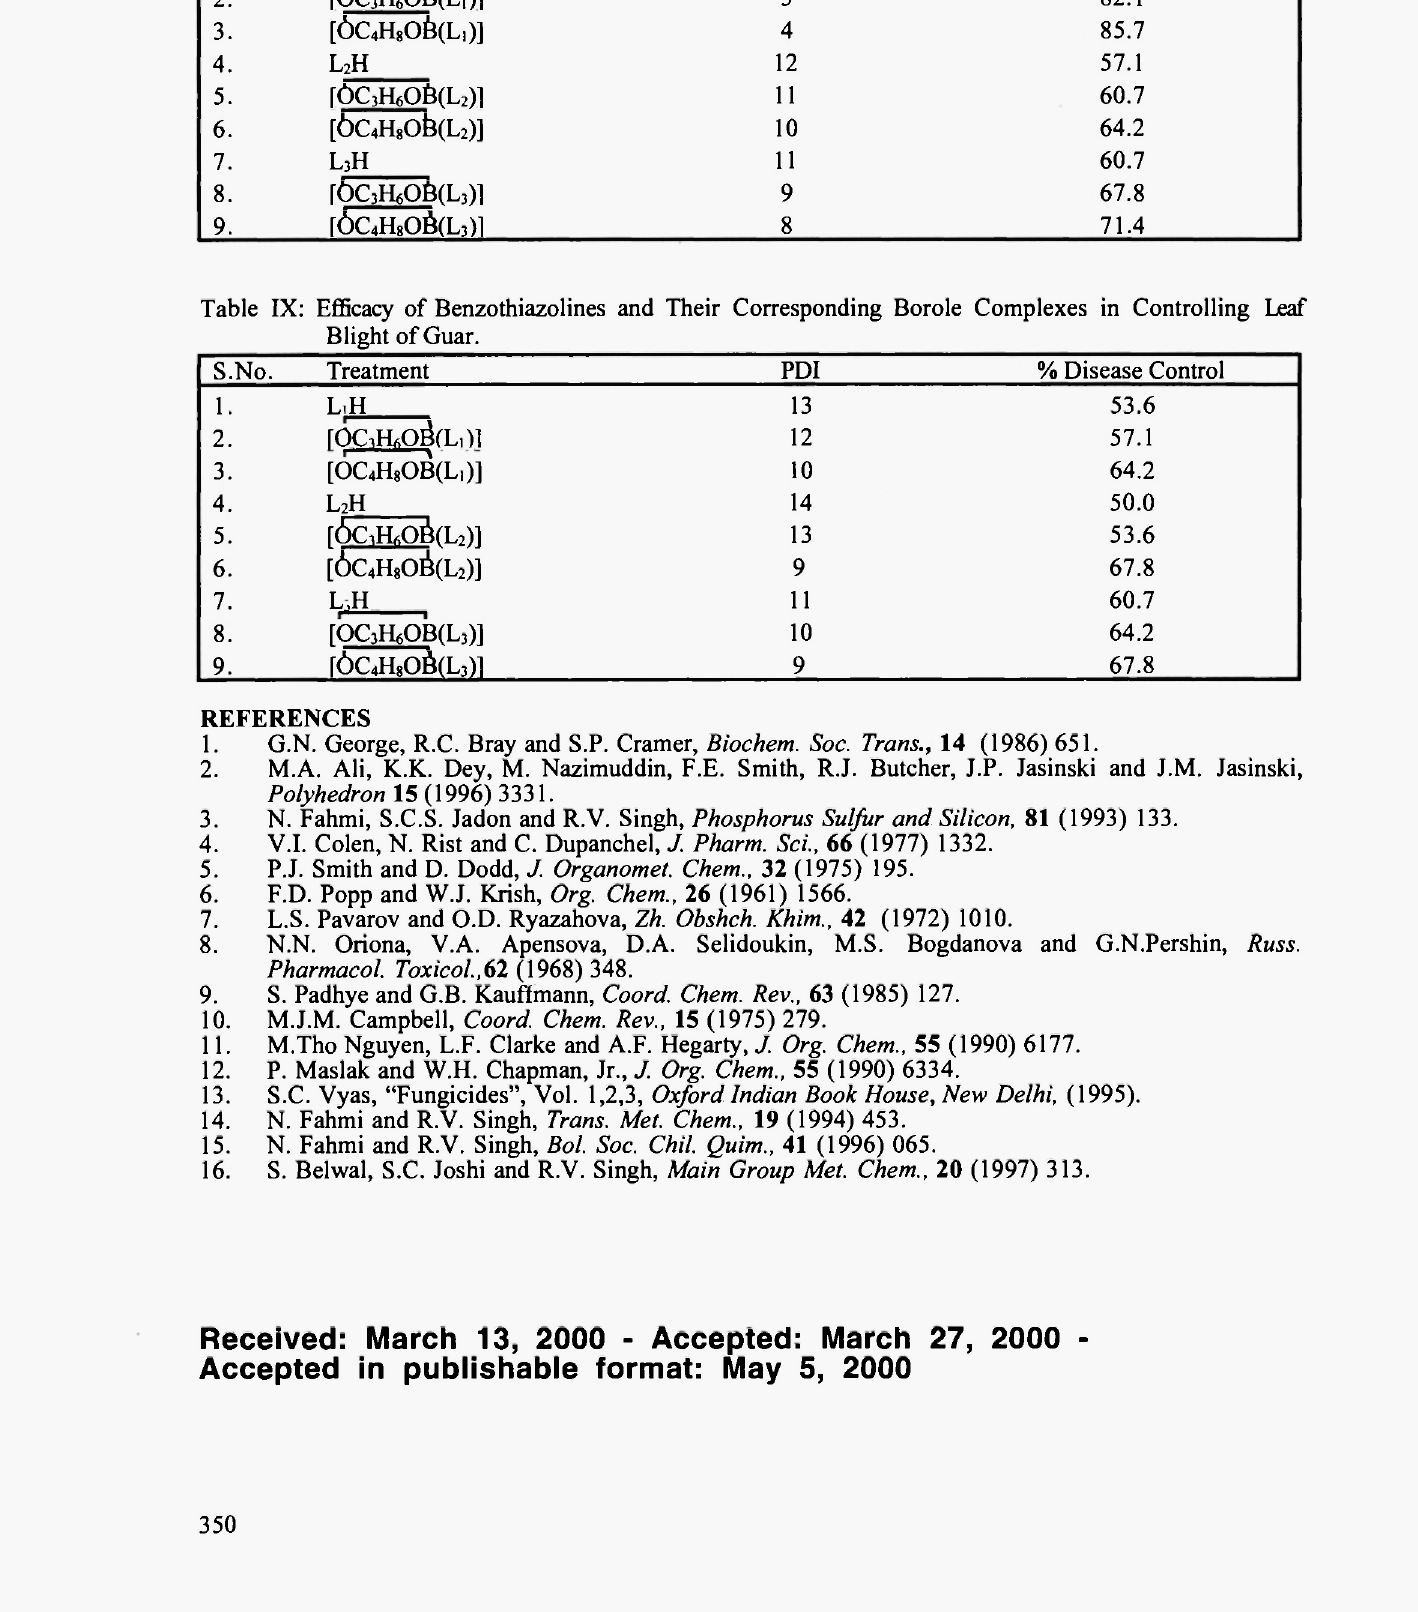
Table VIII: Efficacy of Benzothiazolines and Their Corresponding Borole Complexes in Controlling Web Blight of Moong Beam caused by Rhizoctonia bataticola.